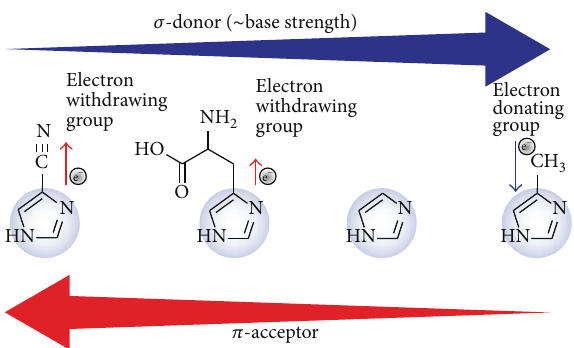
Scheme 11: The effect of the substituent with respect to electron do- nating/accepting capacity on the coordinate